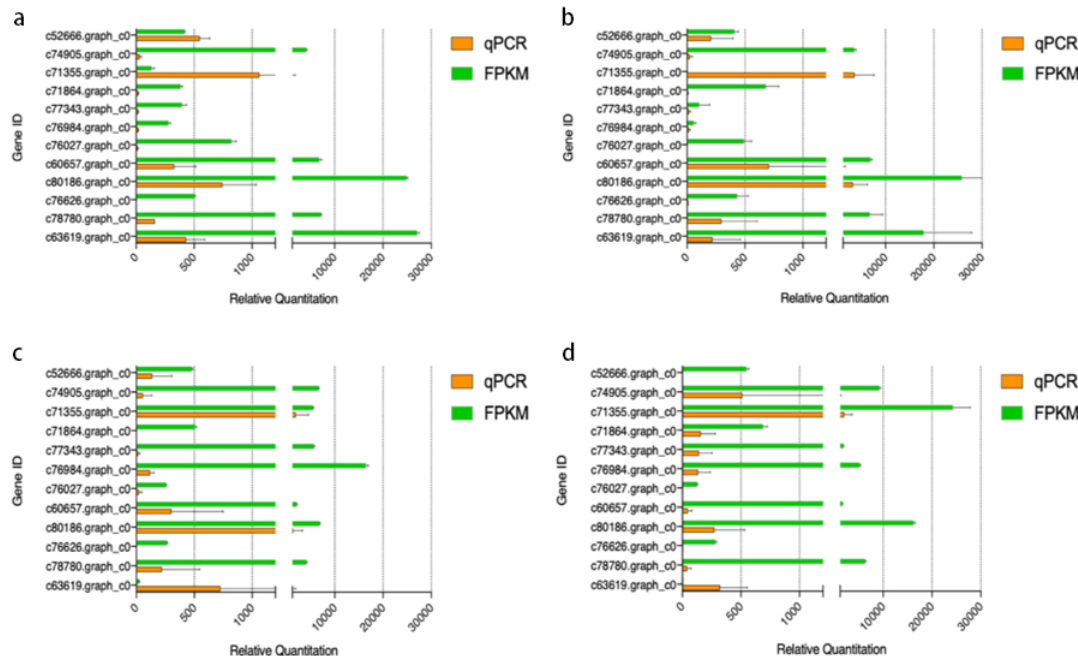
Figure 1. Analysis of differentially expressed genes based on FPKM values in different instars of Monochamus alternatus . ( a ): Shows the expression analysis of 12 differentially expressed genes in the first instar larvae based on FPKM value. ( b ): Shows the expression analysis of 12 differentially expressed genes in the second instar larvae based on FPKM value. ( c ): Shows the expression analysis of 12 differentially expressed genes in the third instar larvae based on FPKM value. ( d ): Shows the expression analysis of 12 differentially expressed genes in the fourth instar larvae based on FPKM value.